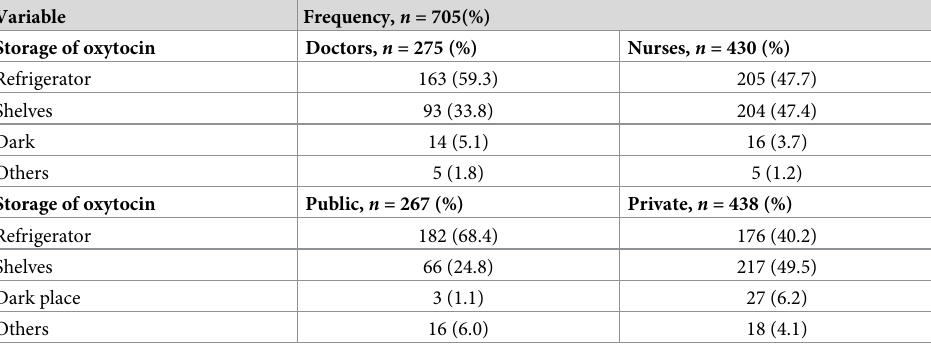
Table 4. Assessment of knowledge of oxytocin storage by Cadre and Sector of practice of